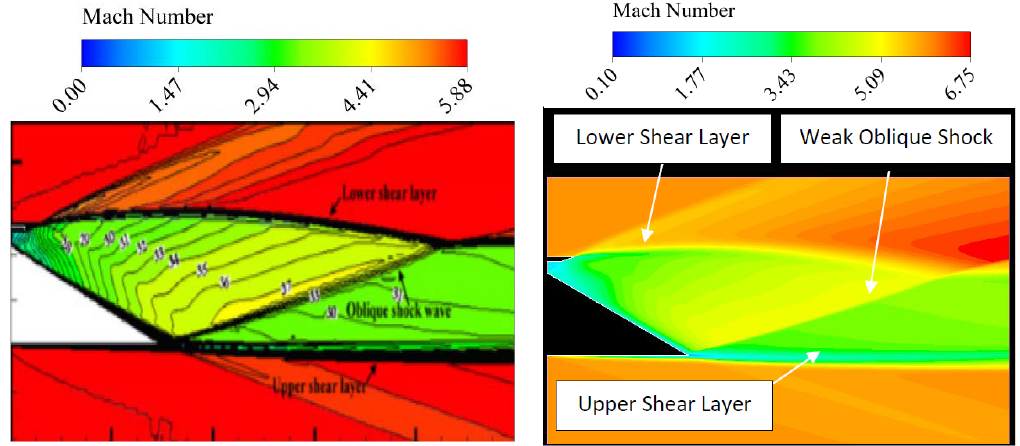
Figure 7. Comparison of Mach number contours between Huang et al. [10] ( left ) and the present analysis ( right ).